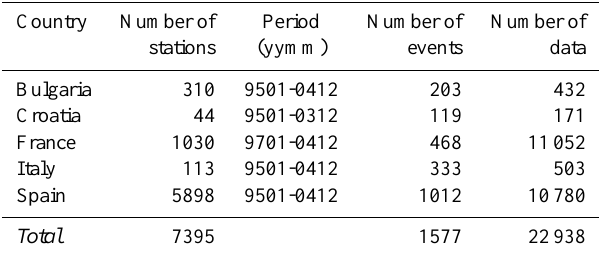
Table 3. Data in the calendars of severe weather events (MEDEX